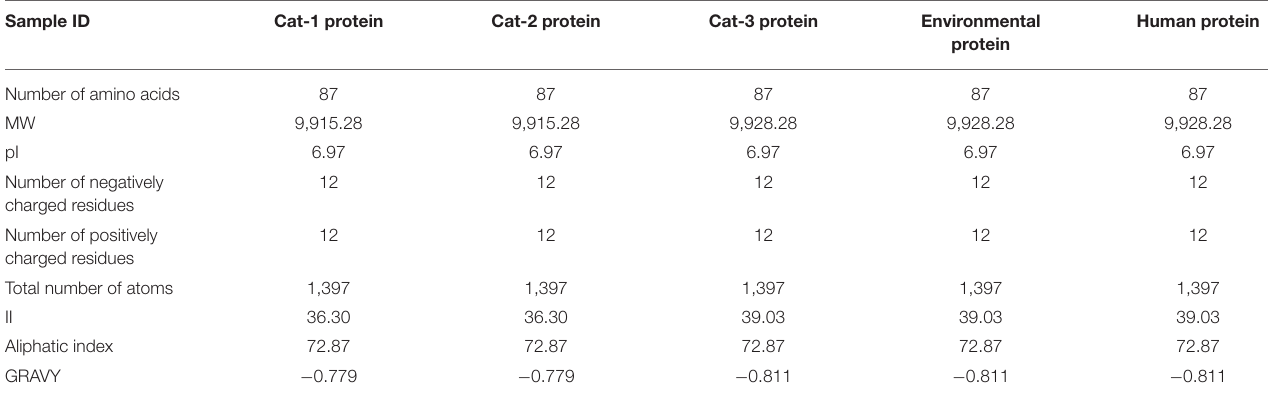
TABLE 5 | Staphylococcus aureus mecA protein physical and chemical properties of proteins (Cat-1. Cat-2, Cat-3, Environmental, and